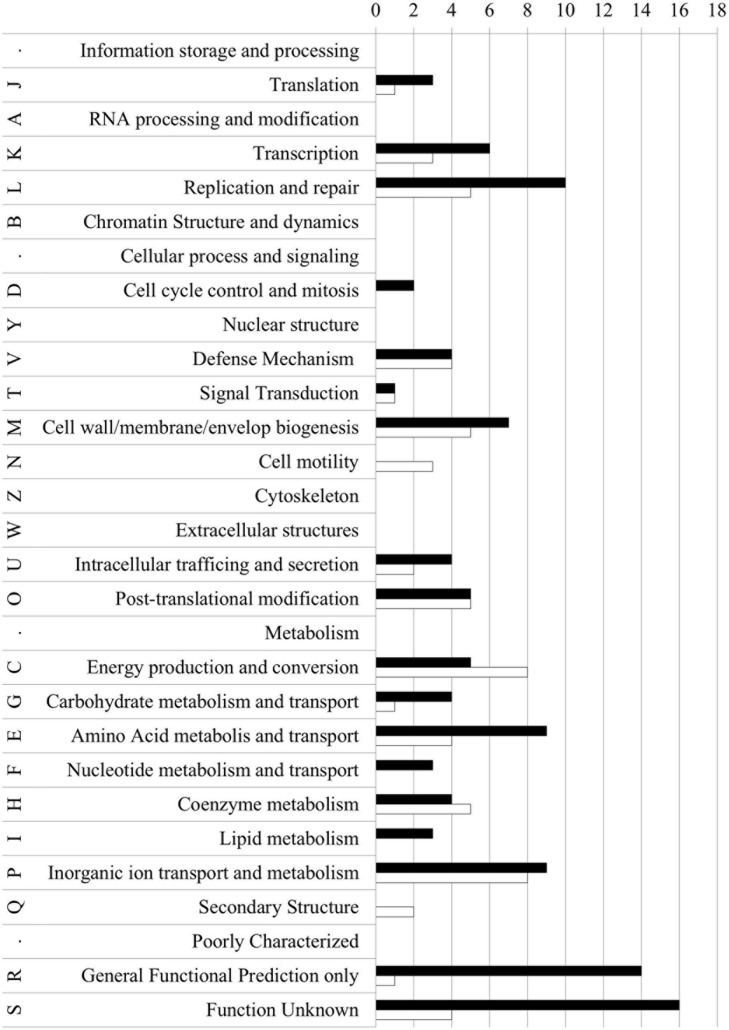
Clusters of orthologous groups classification of proteins encoded by up- and down-regulated genes in the NgoAX knock-out N. gonorrhoeae versus the wt strain. Letters represent COGs categories; numbers – the number of proteins in each category; black bars – proteins encoded by up-regulated genes; white bars – proteins encoded by down-regulated genes.